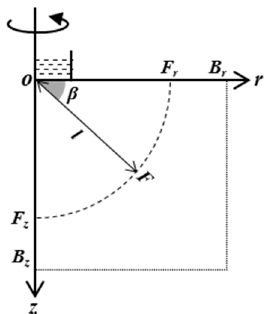
Figure 2. The conceptual model of film hole irrigation.